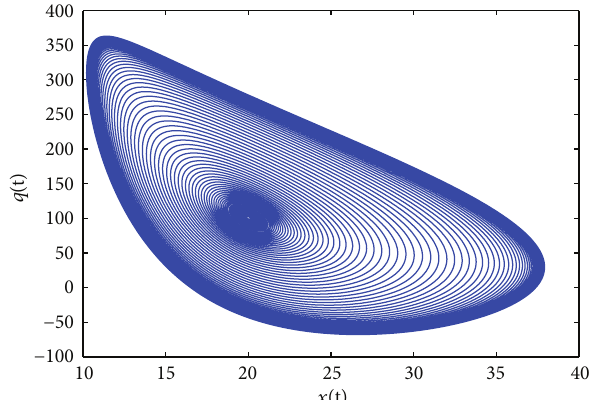
Figure 5: Waveform plot of 𝑡 - 𝑞(𝑡) with 𝜏 = 0.206 .